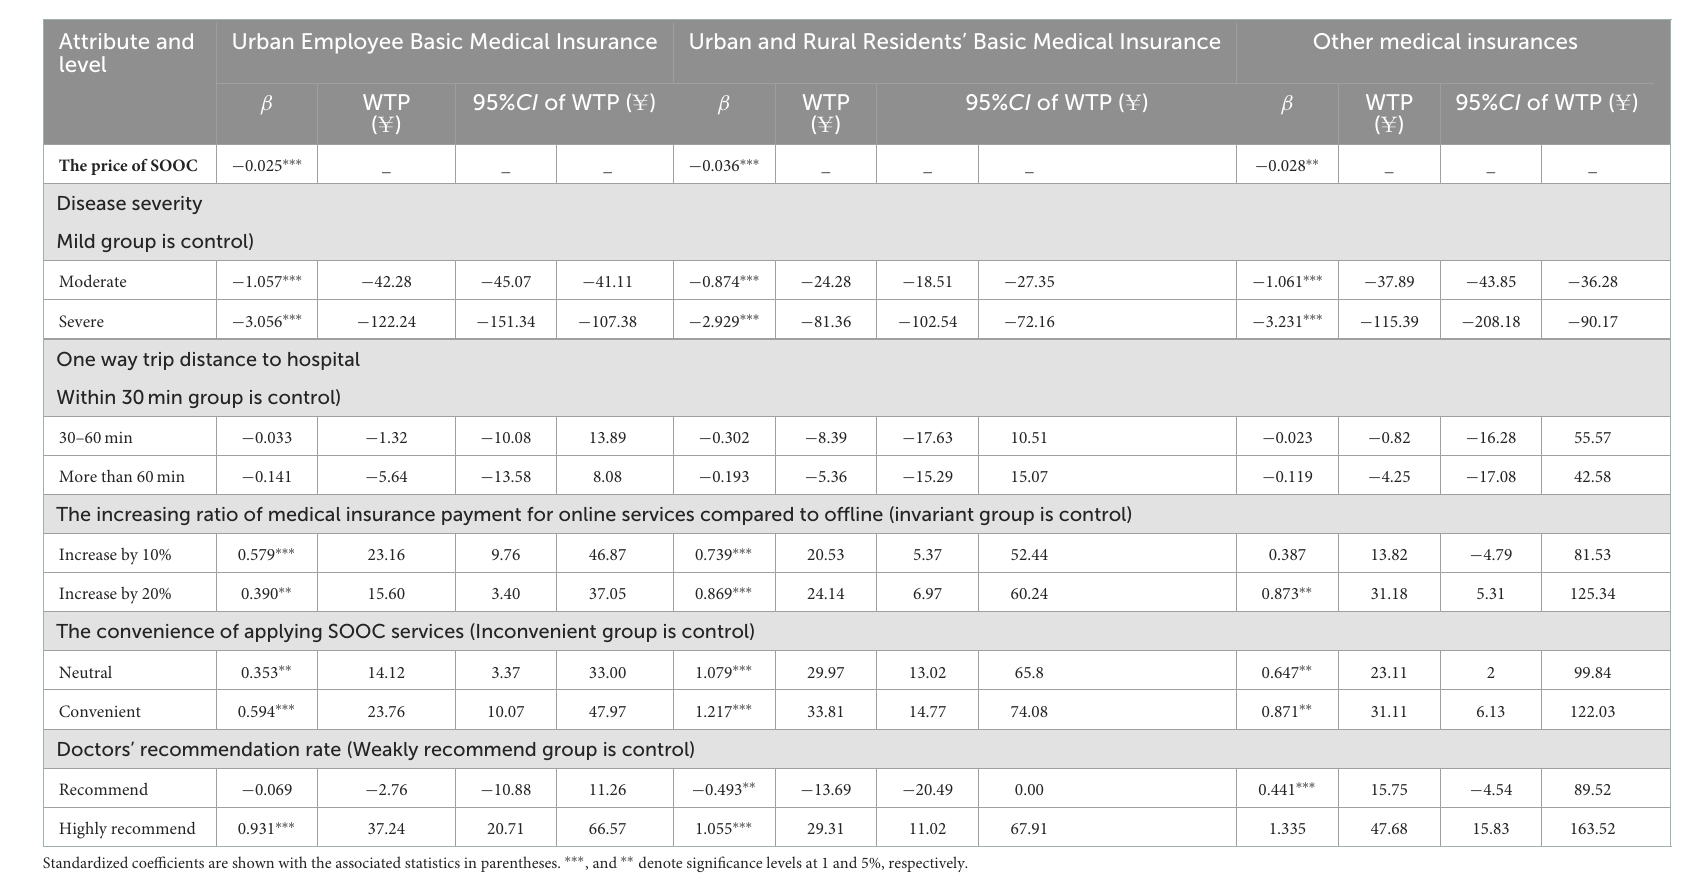
TABLE 9 Conditional logit regression analysis and the WTP of patients with different medical insurance